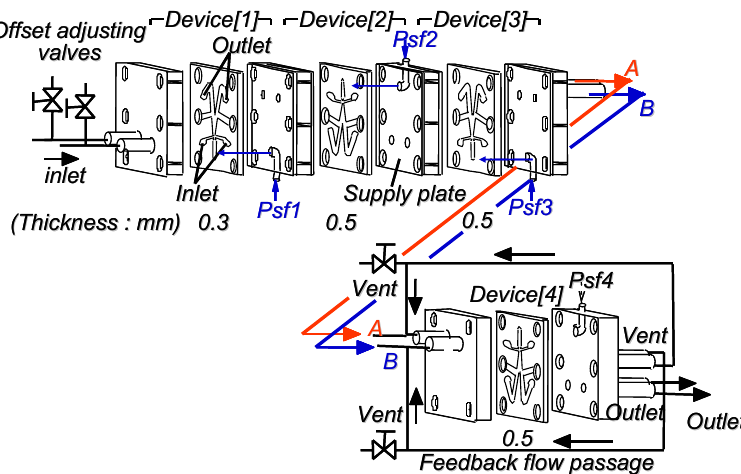
Construction of improved fluid amplifier using feedback passages